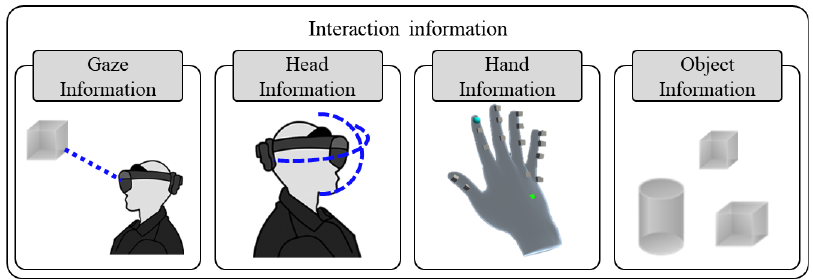
Figure 3. Interaction information used as input for predicting user satisfaction.